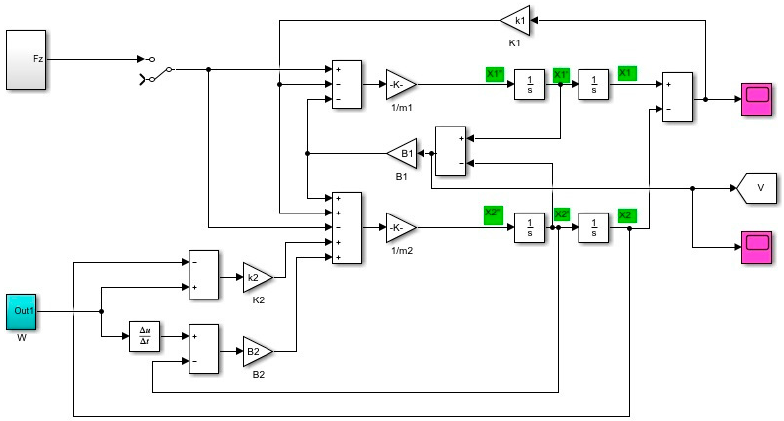
Figure 3. MATLAB / Simulink model [17]. Figure 3. MATLAB/Simulink model [17].